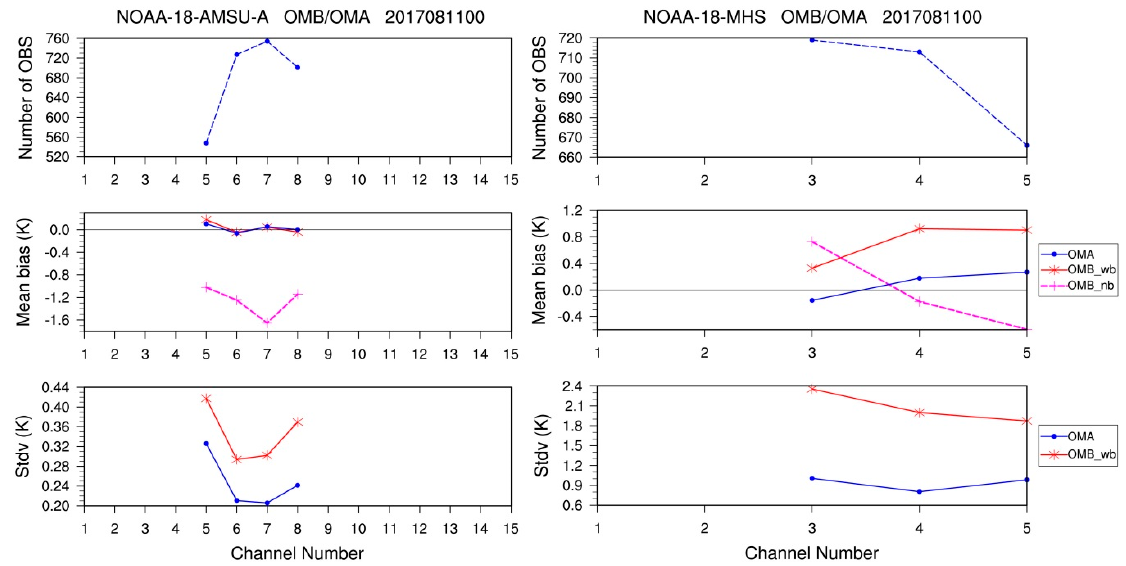
Figure 6. The number of observations, mean bias, and standard deviation (Stdv) of all channels in the AMSU-A and MHS instruments from NOAA-18 for OMB without (OMB_nb) and with (OMB_wb) BC and OMA at 0000 UTC on 1 August 2017. OMB: observation minus background; OMA: observation minus analysis.